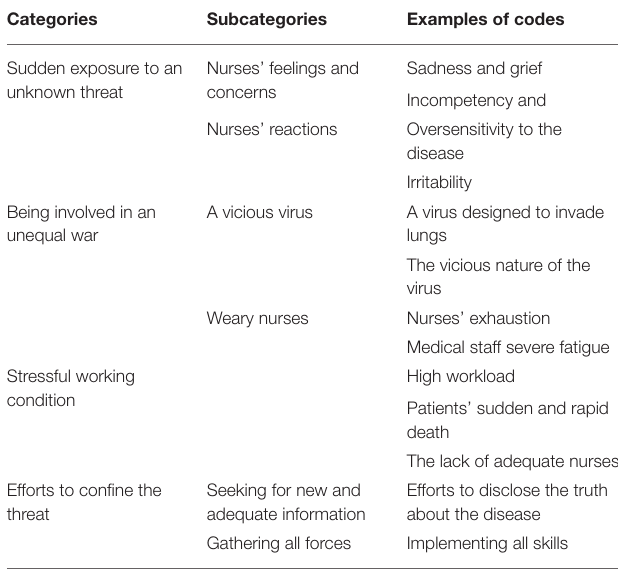
TABLE 2 | The categories and subcategories extracted from the experiences of the nurses providing care to COVID-19 patients.